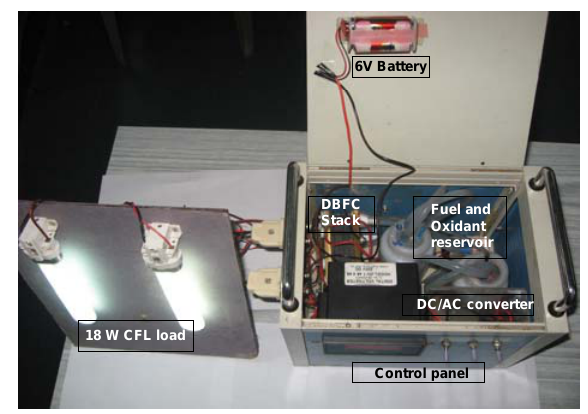
Figure 8. Self-supported DBFC